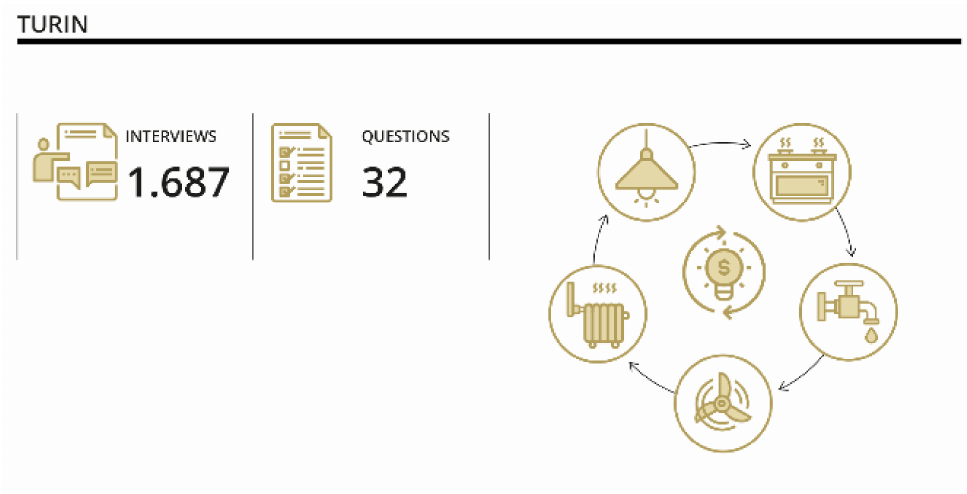
Figure 1. The rationale of this study is re-examining old projects and reliving significant messages for current CS activities. Project #1, analysis of the energy consumption of one urban district at family level. The Crocetta district of Turin, 12,000 inhabitants km − 2 , was identified for its average social homogeneity and for the availability of preliminary data on the electricity and gas